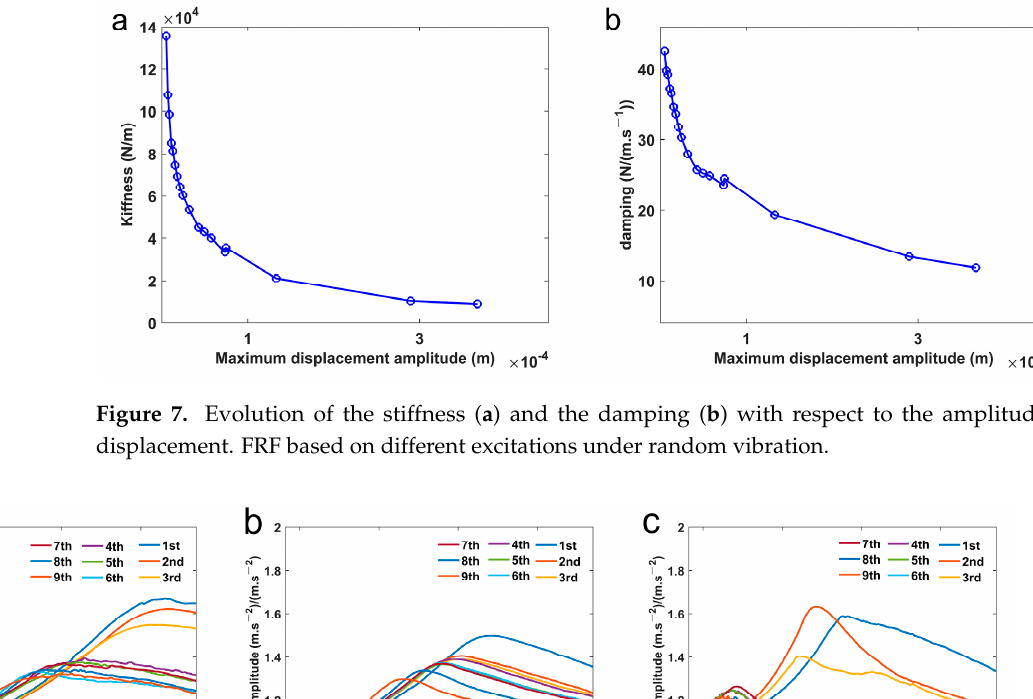
Figure 8. FRF based on different excitations under random vibration: ( a ) 50 g; ( b ) 60 g; ( c ) 70 g. In order to elucidate the fatigue lifetime decay of elastic rubber isolators with random vibration, the functions of the mean value of random acceleration and the stiffness decay of isolator stiffness were established. Figure 9a illustrates the results of repeated accelerated lifetime test when the load mass is 50 g, indicating that stiffness decreases as the time of the experiments increases. It is illustrated that under the same load mass, the stiffness decay of the rubber isolator remains basically the same every time a random vibration experiment is repeated. Therefore, the arithmetic mean value of the stiffness decay after each random vibration experiment of repeated experiments is calculated to represent the stiffness value corresponding to the acceleration mean value under the load. In the early stage of the accelerated lifetime test, the stiffness decreases significantly. As the random vibration experiment repeats, the stiffness declines stably. Finally, when the stiffness approaches the experimental cut-off threshold, the stiffness drops sharply. Figure 9b shows that as the load mass increases, the isolator stiffness decreases even more. Notably, the stiffness value at the end of the experiment decreases, indicating that the load mass of the random vibration experiment produces a profound effect on the fatigue lifetime of the rubber isolator.